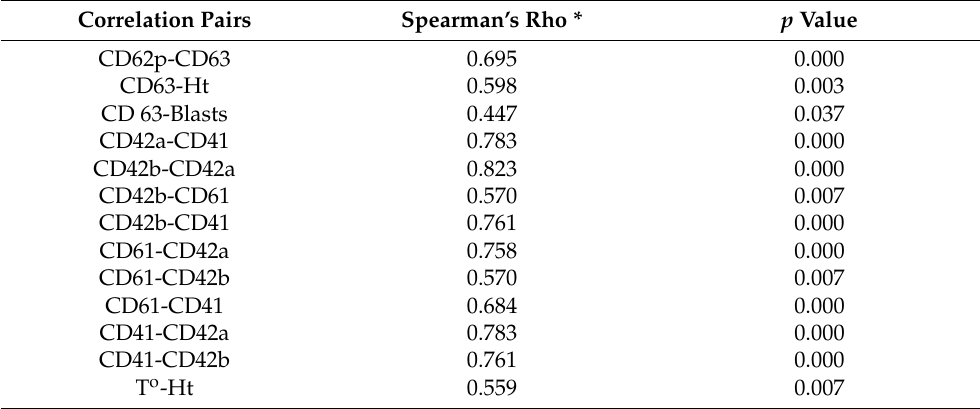
Table 3. Statistical correlations in AML group.